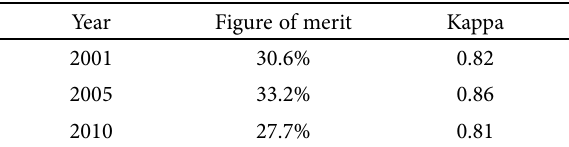
Table 2. Quantitative assessment of accuracy based on cell by